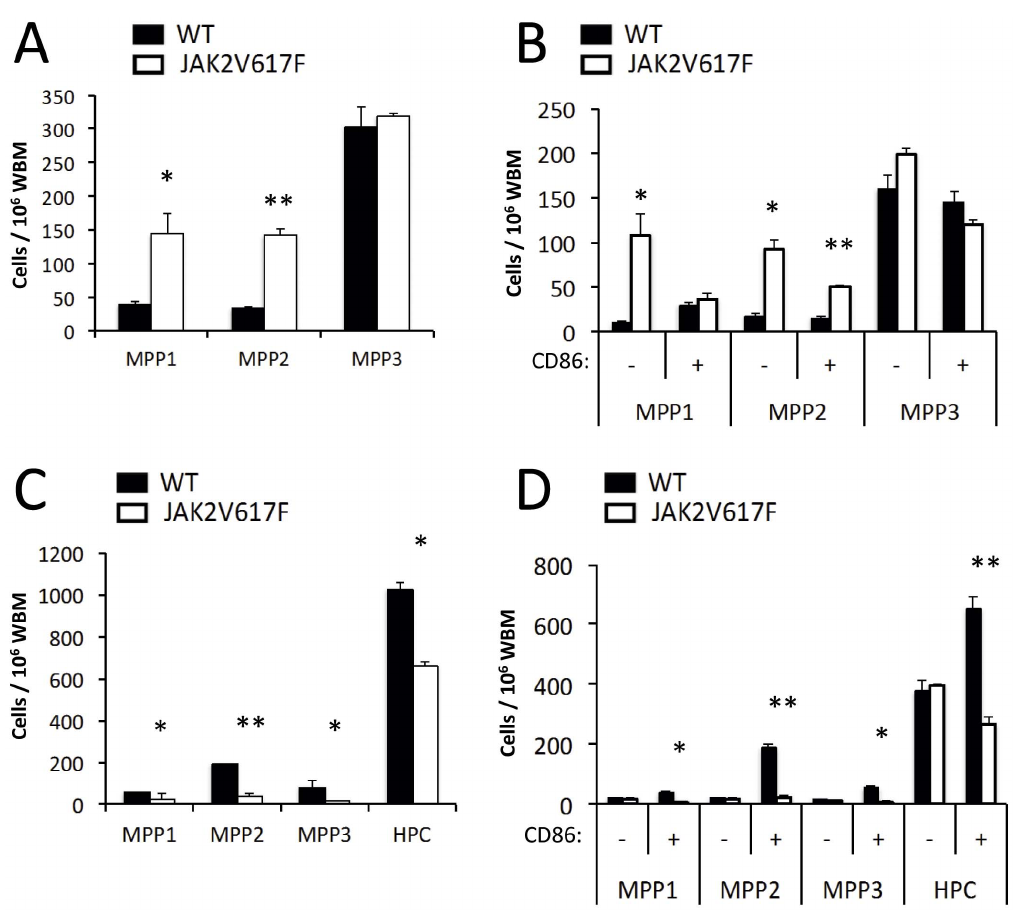
Figure 4. Multipotent progenitors are altered in JAK2V617F Tg mice. ( A ) LSK from control and Tg mice were resolved with CD150, CD48, Flk2 and CD34 staining into MPP subsets as described by Trumpp and colleagues [45]. The subset definitions are CD150 + CD48 2 CD34 + LSK (MPP1), CD150 + CD48 + CD34 + LSK (MPP2) and CD150 2 CD48 + CD34 + LSK (MPP3). ( B ) These populations were further subdivided on the basis of CD86 expression. ( C ) Morrison and colleagues exploited CD150, CD48, CD229 and CD244 to define MPP subsets [46], and ( D ) again we subdivided them on the basis of CD86 display. The surface markers define CD150 2 CD48 2 CD229 2 CD244 2 (MPP1), CD150 2 CD48 2 CD229 + CD244 2 (MPP2), CD150 2 CD48 2 CD229 + CD244 + (MPP3), and CD150 2 CD48 + (HPC). The results are given as the percentages of BM cells and are representative of those obtained in two independent experiments (N=3). Despite the common nomenclature used with these methods, distinct subsets and possibly separate differentiation pathways are identified (See Figure